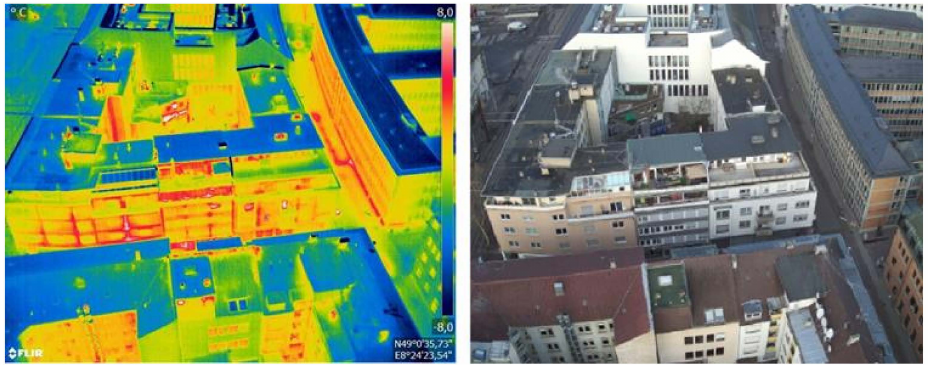
Figure 3. Thermographic aerial panorama image ( left ) with the corresponding RGB aerial panorama image ( right ) of inner-city buildings in Karlsruhe.